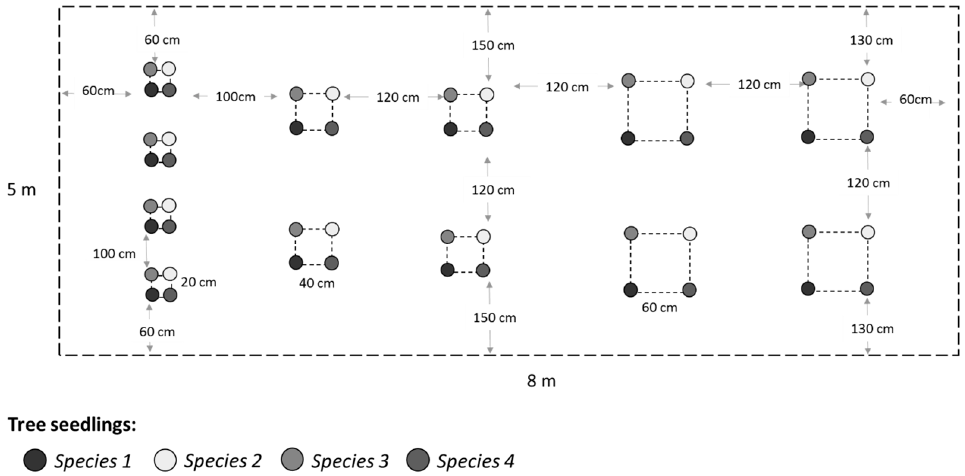
Figure 3. A plot showing tree seedling plantation arrangements. The seedling position is shown by the circle and the grayscale legend shows a distinct species.